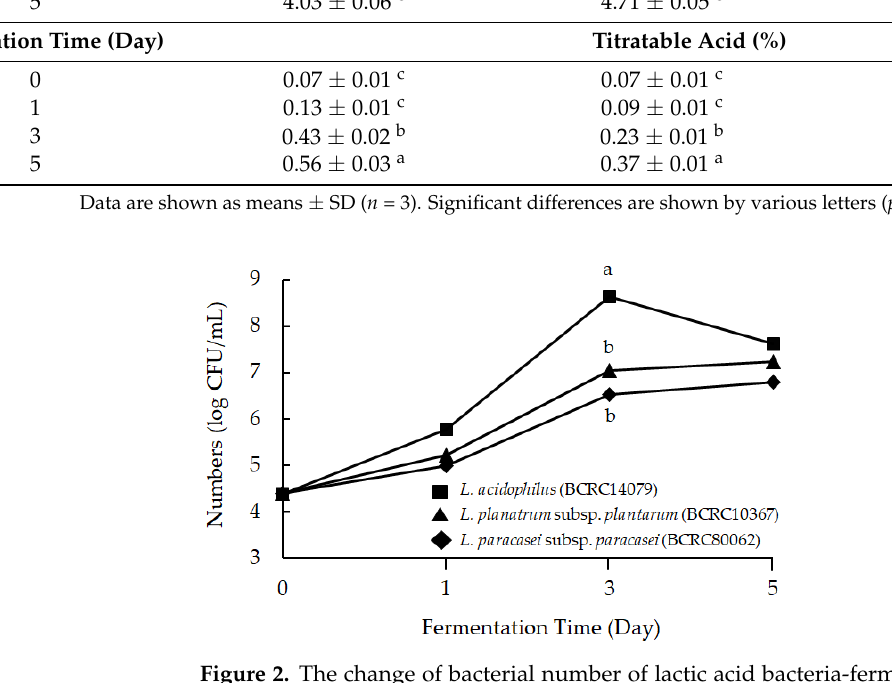
Figure 2. The change of bacterial number of lactic acid bacteria-fermented mango peel. Data are shown as means ± SD ( n = 3). Significant differences are shown by various letters ( p < 0.05). Table 2. The changes of pH and titratable acid in L. acidophilus (BCRC14079)-fermented-mango peel